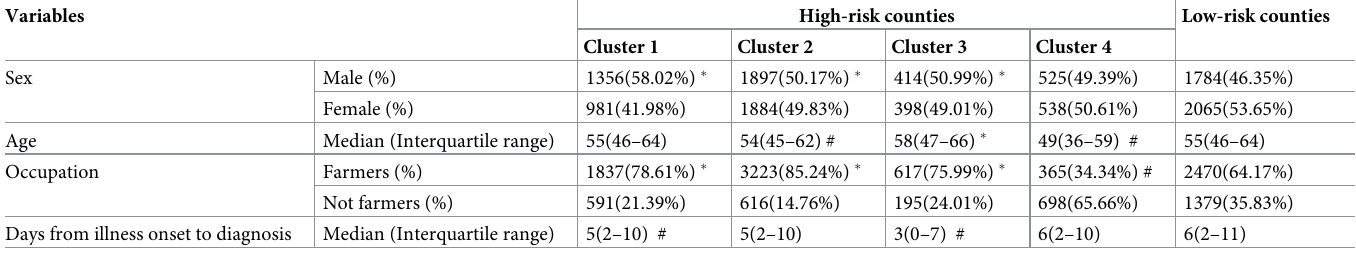
Table 5. Comparison of characteristics of scrub typhus cases between high-risk counties and low-risk counties identified by Kulldorff’s spatiotemporal scan statistic in Fujian Province, 2012–2020. Variables